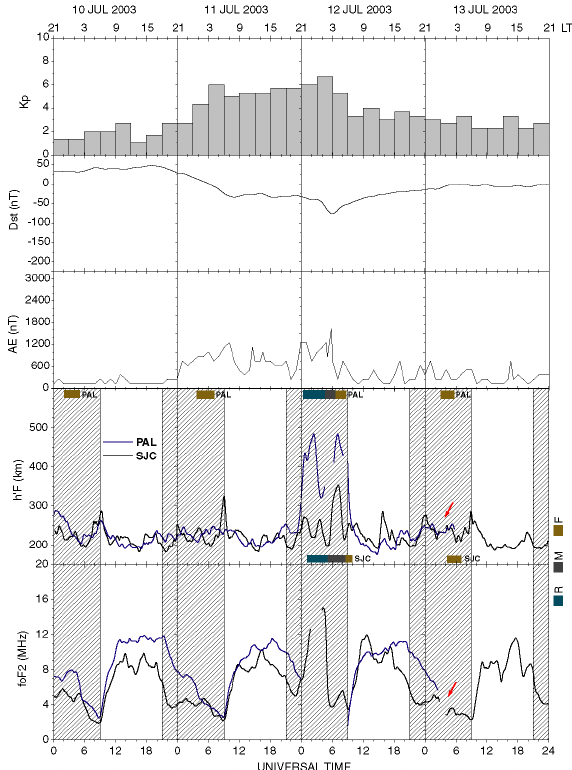
Fig. 3. Same as Fig. 2a, except for the period of 2 to 7 November 2000.